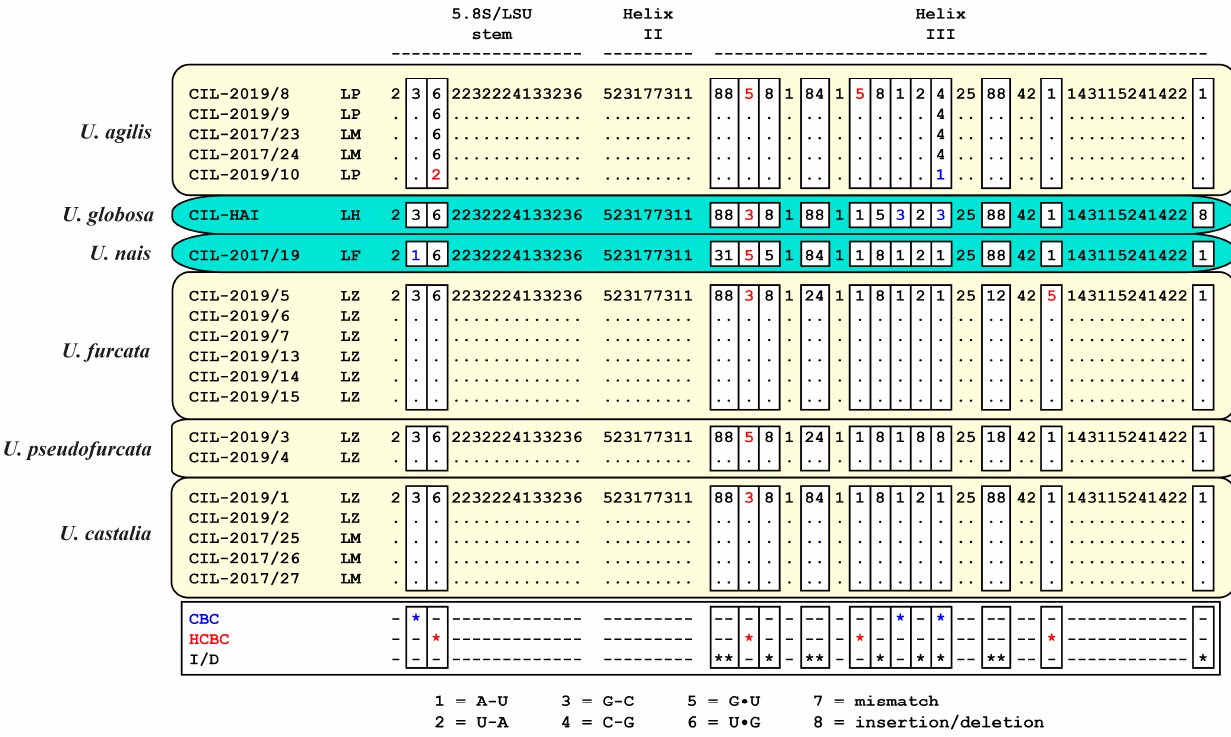
Figure 7. Comparison of the conserved region of ITS-2 among the species of Urotricha translated into number codes used as barcodes. Differences among the species are highlighted in white boxes.